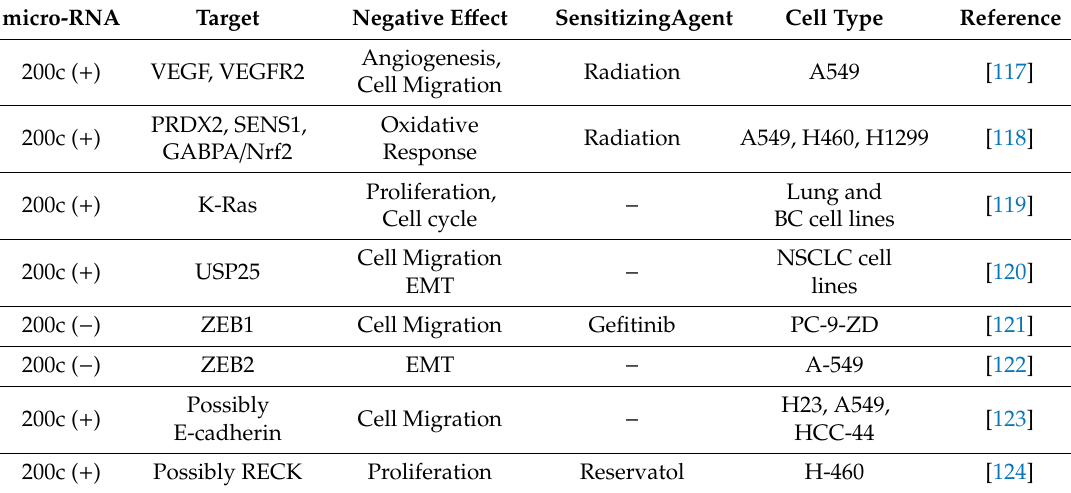
Table 3. Elevated ( + ) or reduced ( − ) miRNA-200c levels are shown, as are their target genes, their biological e ff ects and whether these factors can sensitize cells to certain therapeutic agents. The cell types indicate the types of cells characterized. BC, breast cancer; NSCLC, non-small cell lung cancer.